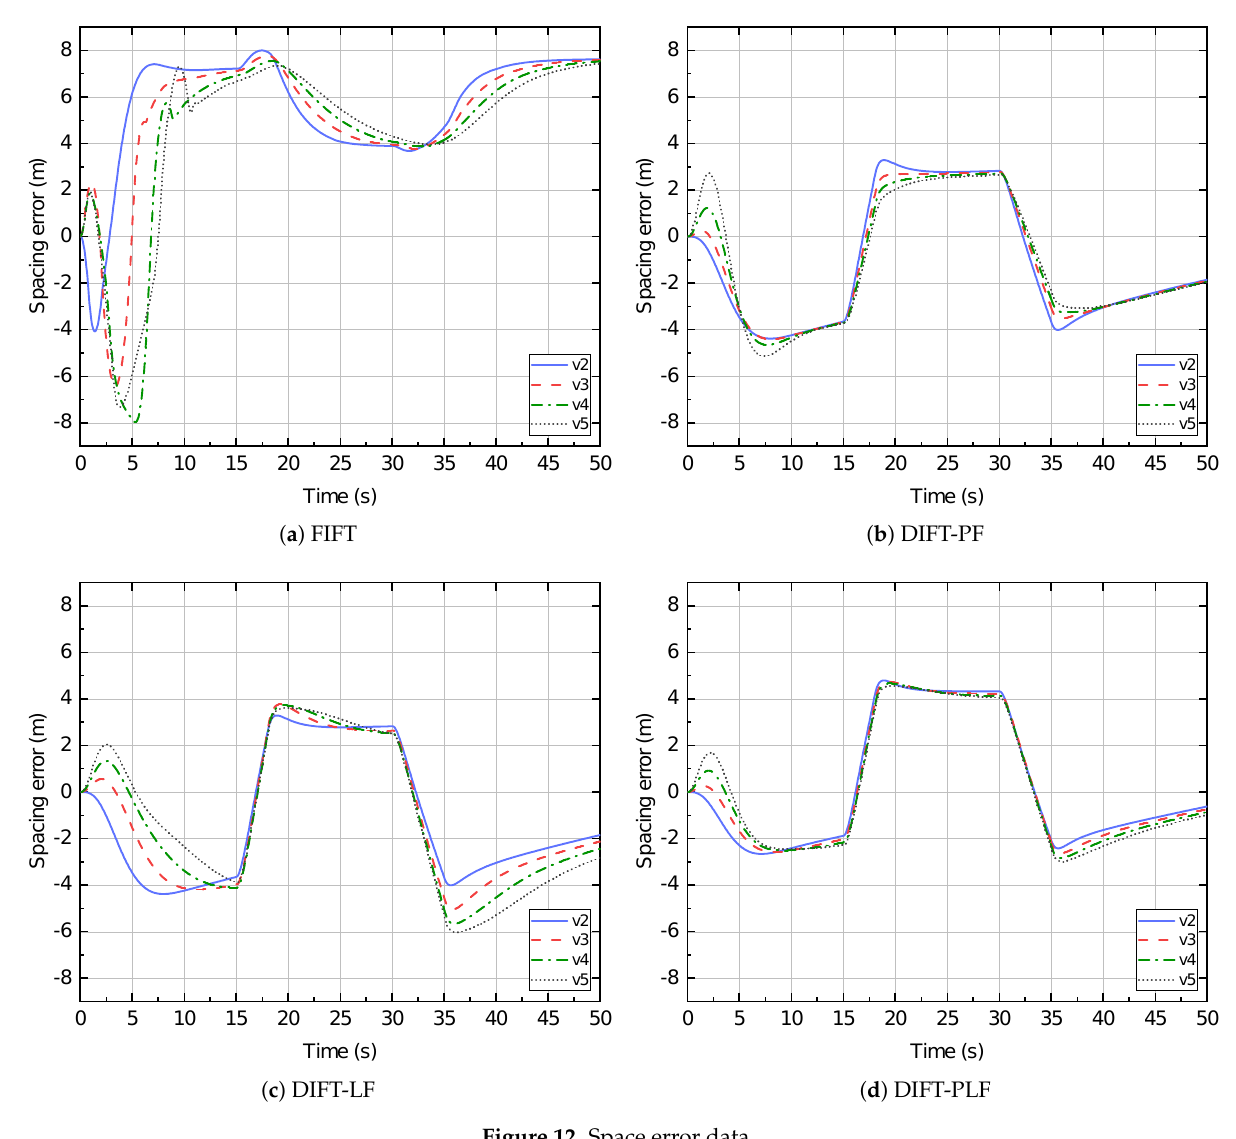
Figure 12. Space error